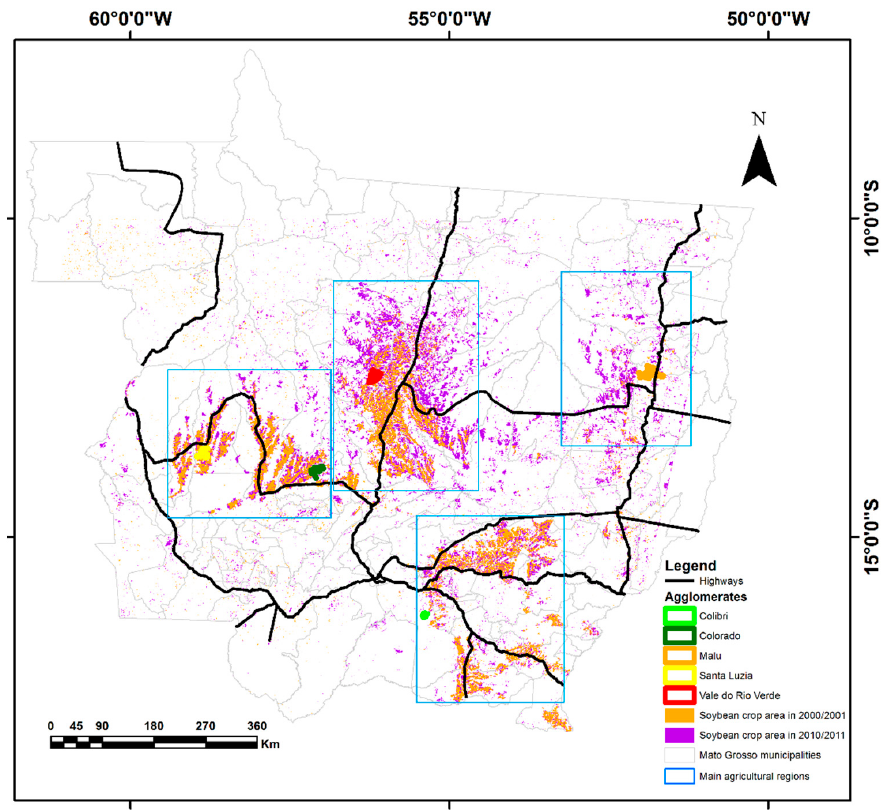
Figure 3. Geographic location of the Colibri, Colorado, Malu, Santa Luzia and Vale do Rio Verde agglomerates used for the validation phase. The four main agricultural regions of Mato Grosso are indicated in blue.